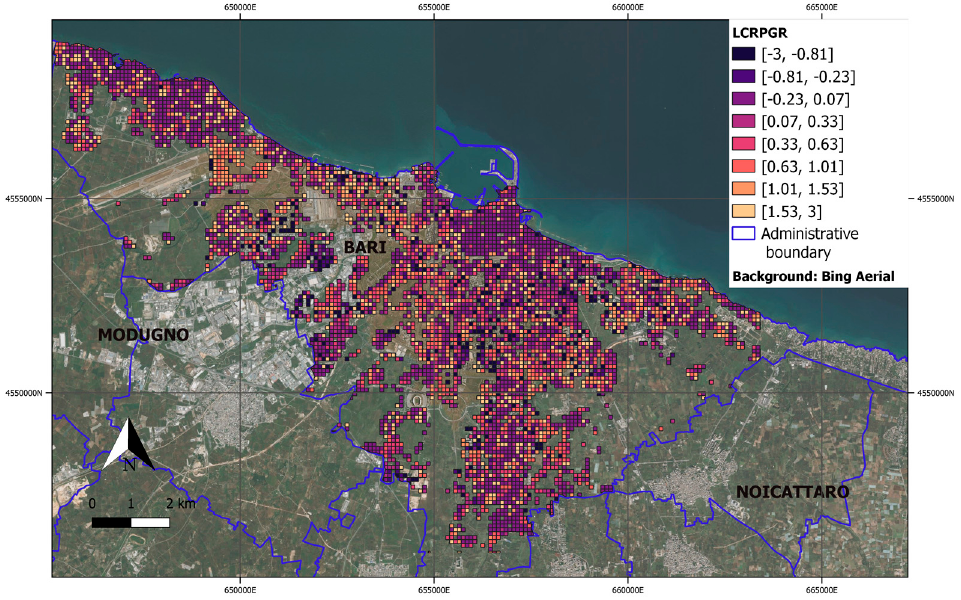
Figure 26. SDG 11.3.1 Indicator: LCRPGR.